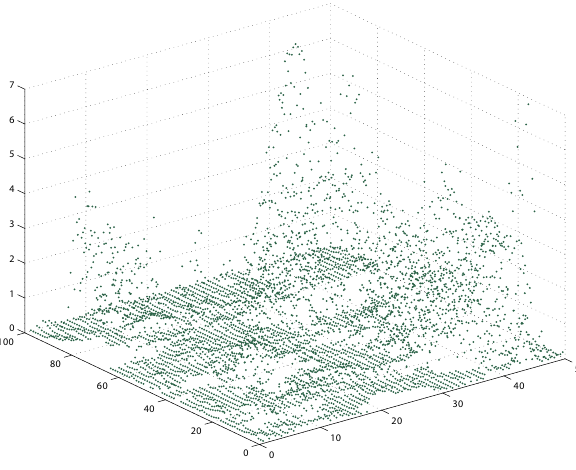
Fig. 5. Detrended roughness heights for the 1m-resolution refer- ence DEM studied floodplain detail, (m). The origin of the plot corresponds to the corner of the detailed rectangle in Fig. 1, which is downstream and closer to the river